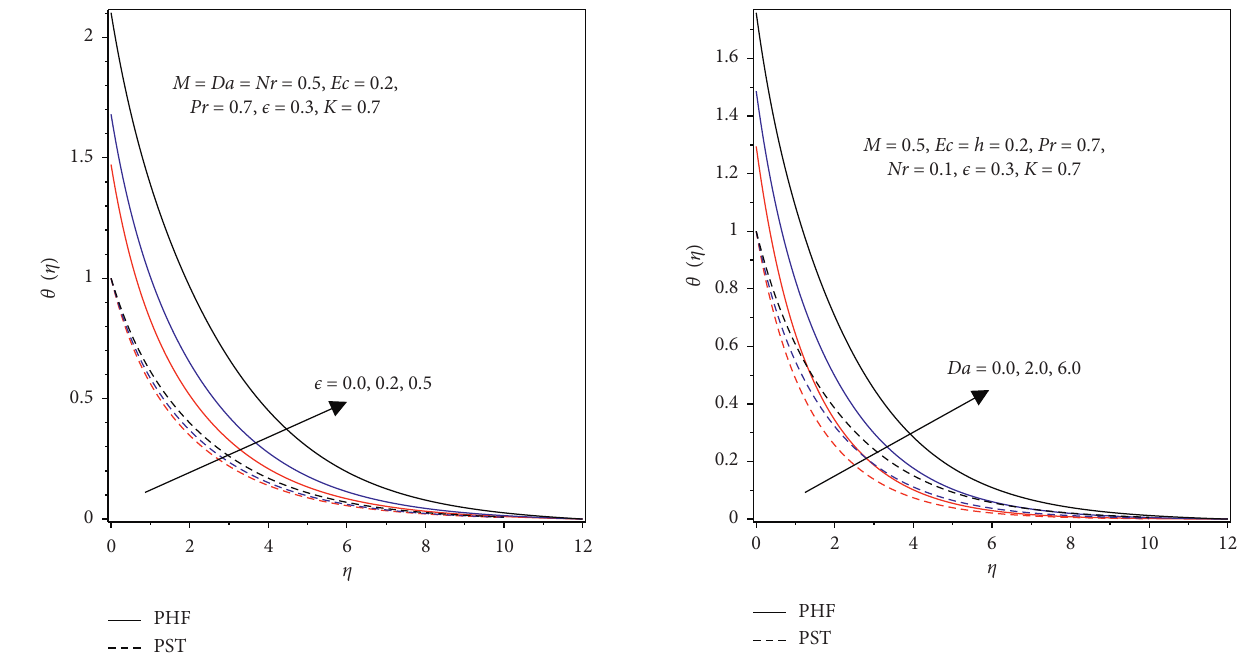
Figure 3: Thermal conductivity parameter ϵ variation with tem- perature profiles.